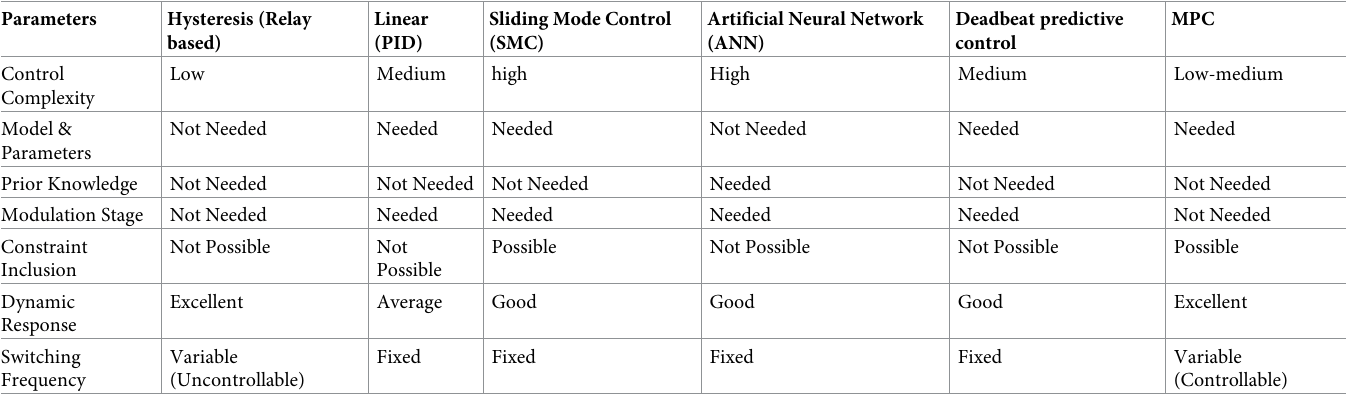
Table 1 tabulates seven parameters for comparison of MPC with different control tech- niques [31]. Dynamic response of hysteresis technique is as good as MPC is while MPC is bet- ter than hysteresis in terms of constraint inclusion and variable switching frequency. MPC is better than PID based linear control technique as MPC don’t require any modulation stage. Table 1. Comparison of existing techniques with MPC